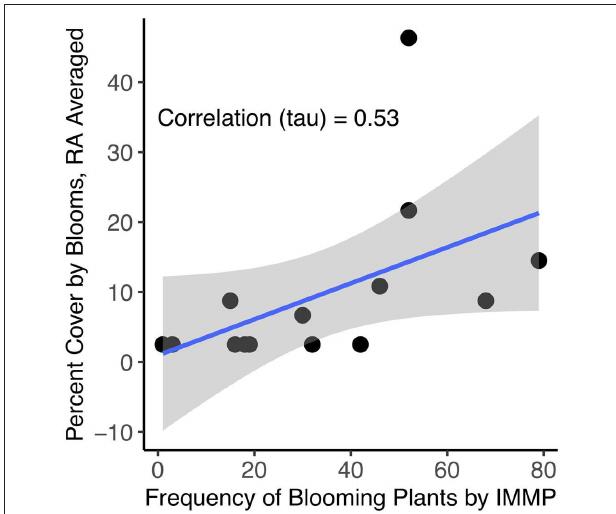
FIGURE 8 | Comparing frequency of nectar plants to estimate of percent cover by blooms in the RA plots, averaged per site, for 2018 sites ( n = 14); percent cover classes were converted to midpoints prior to averaging. Correlation (tau) = 0.53 ( z = 2.477, p -value =